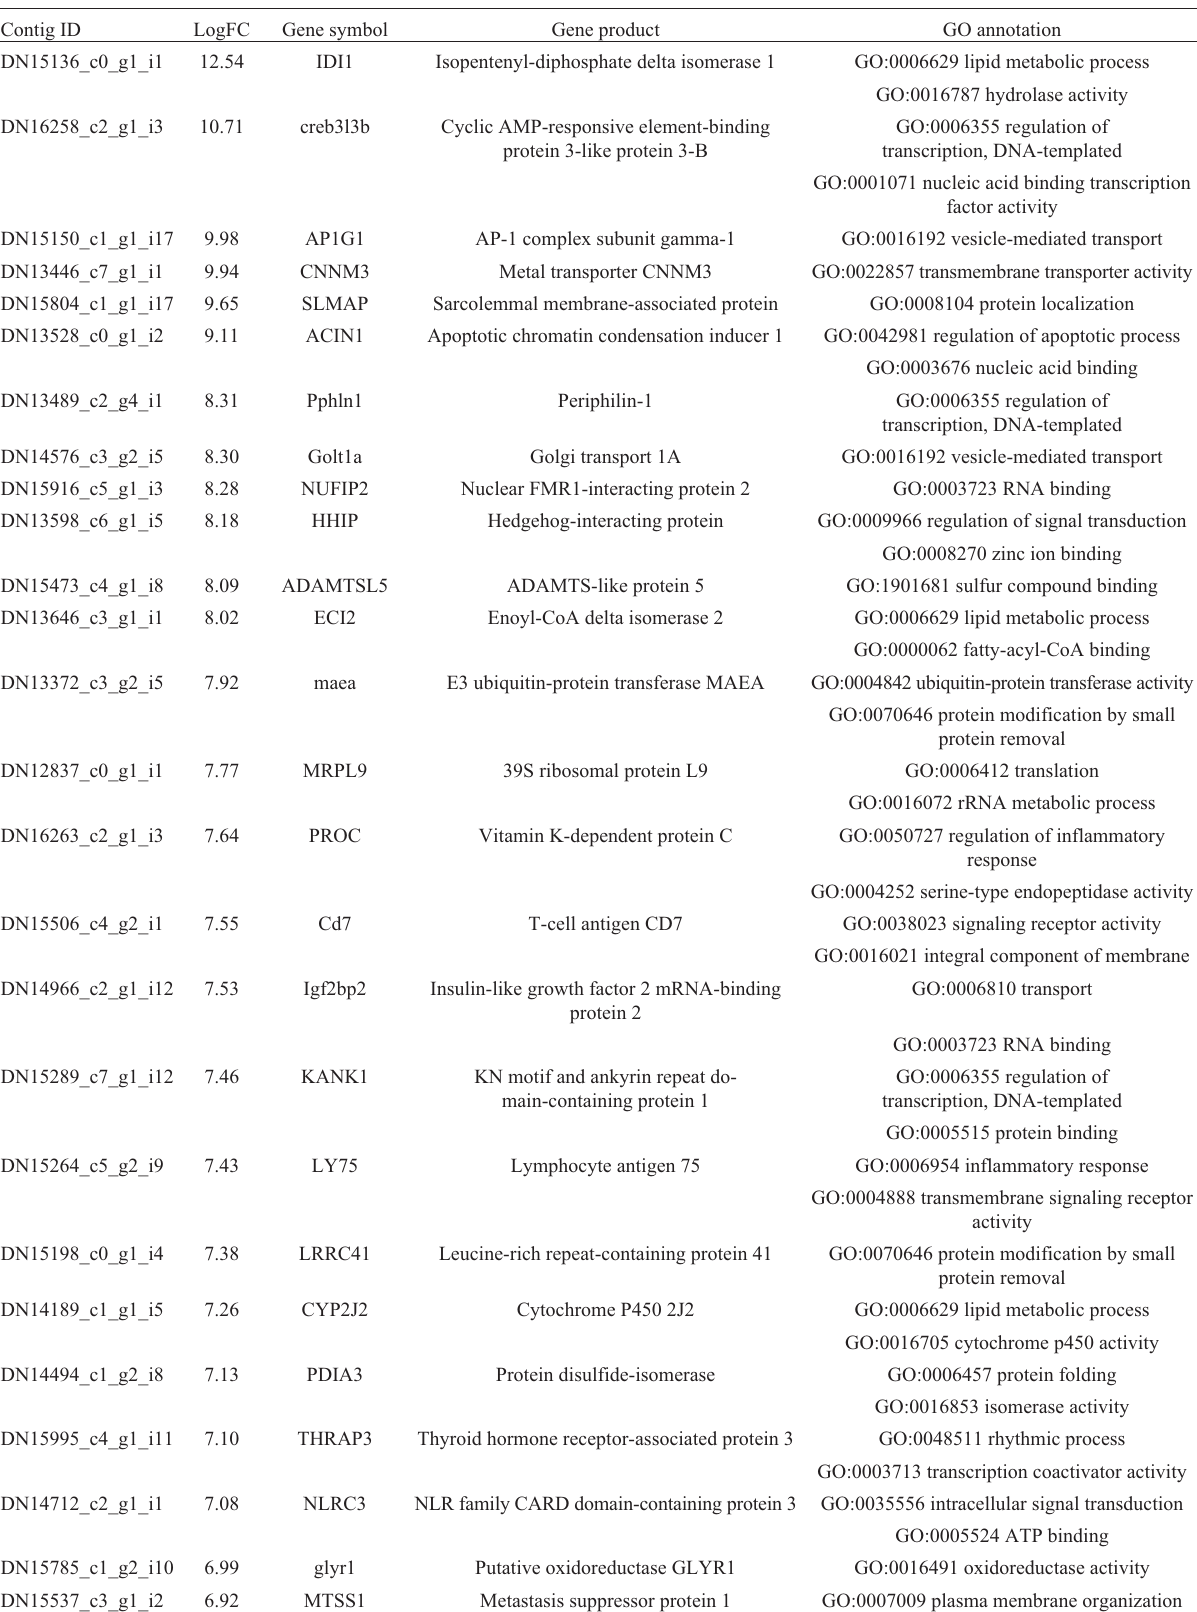
Table 2 - Common terms identified between populations of tambaqui sourced from the Balbina and Brumado fish farms. Contig